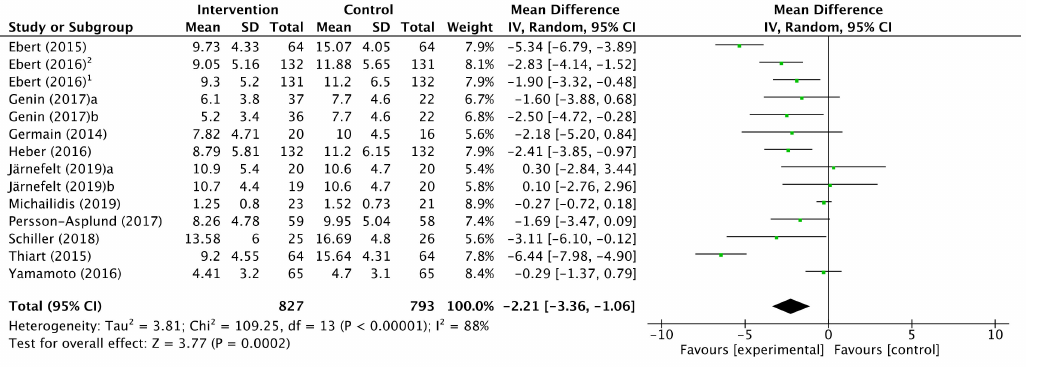
Figure 2. Forest plot of e ff ectiveness of workplace interventions for insomnia symptoms reduction in accordance with Insomnia Severity Index.